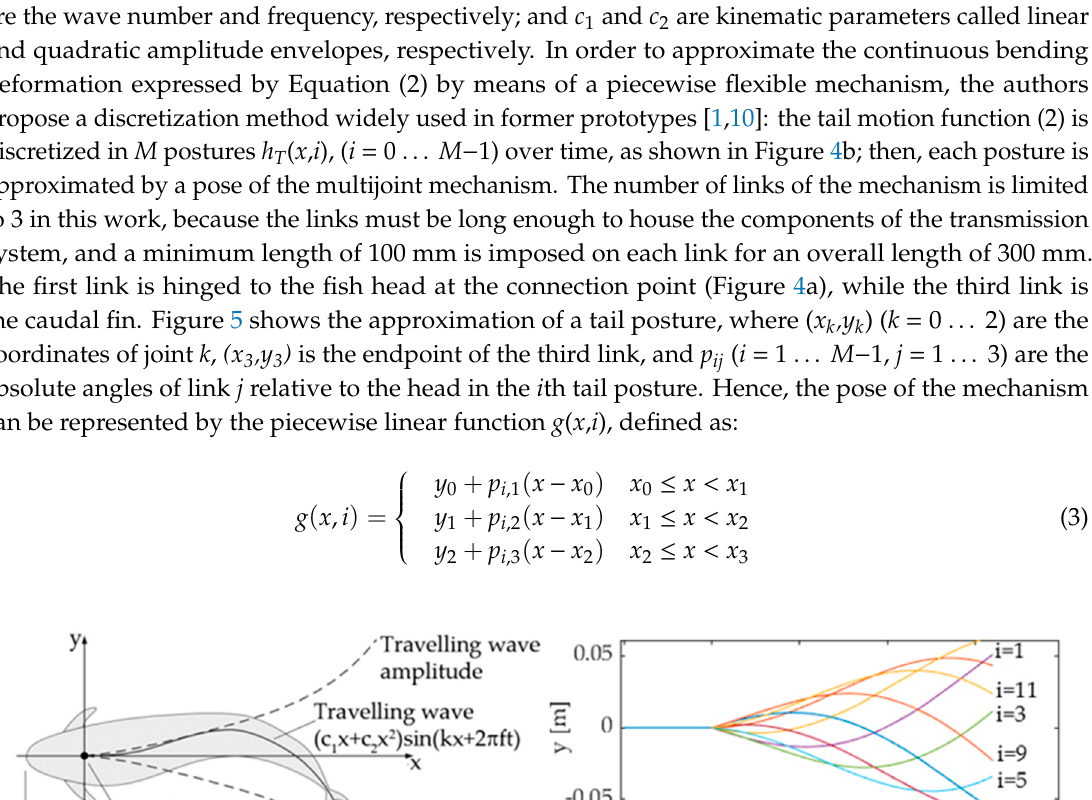
Figure 6. Optimal pose of the linkage corresponding to five tail postures. 2.2. Elements of the Cam-Joint-Based Transmission System In [6], the authors of this paper designed a transmission mechanism to drive the caudal fin of an ostraciiform swimming robot. The core of the system is the spatial cam kinematic joint shown in Figure 7a. The aim is to transform the input rotary motion of the motor into a harmonic oscillation of the output shaft. The driving disk A has a drive sphere B. which engages in a rectangular groove of the driven member C. The oscillating output shaft is rigidly connected with the element C and is also able to pivot freely in the support block D. The arrangement is compact and the axis of rotation of the output is perpendicular to the input. The maximum rotation of the output shaft is twice the angle θ 0 shown in Figure 7b. Figure 7. ( a ) CAD model of the spatial cam kinematic joint. ( b ) Functional scheme [1,6]. More generally, the output angle θ and the motor rotation ϕ are related by the following expression: